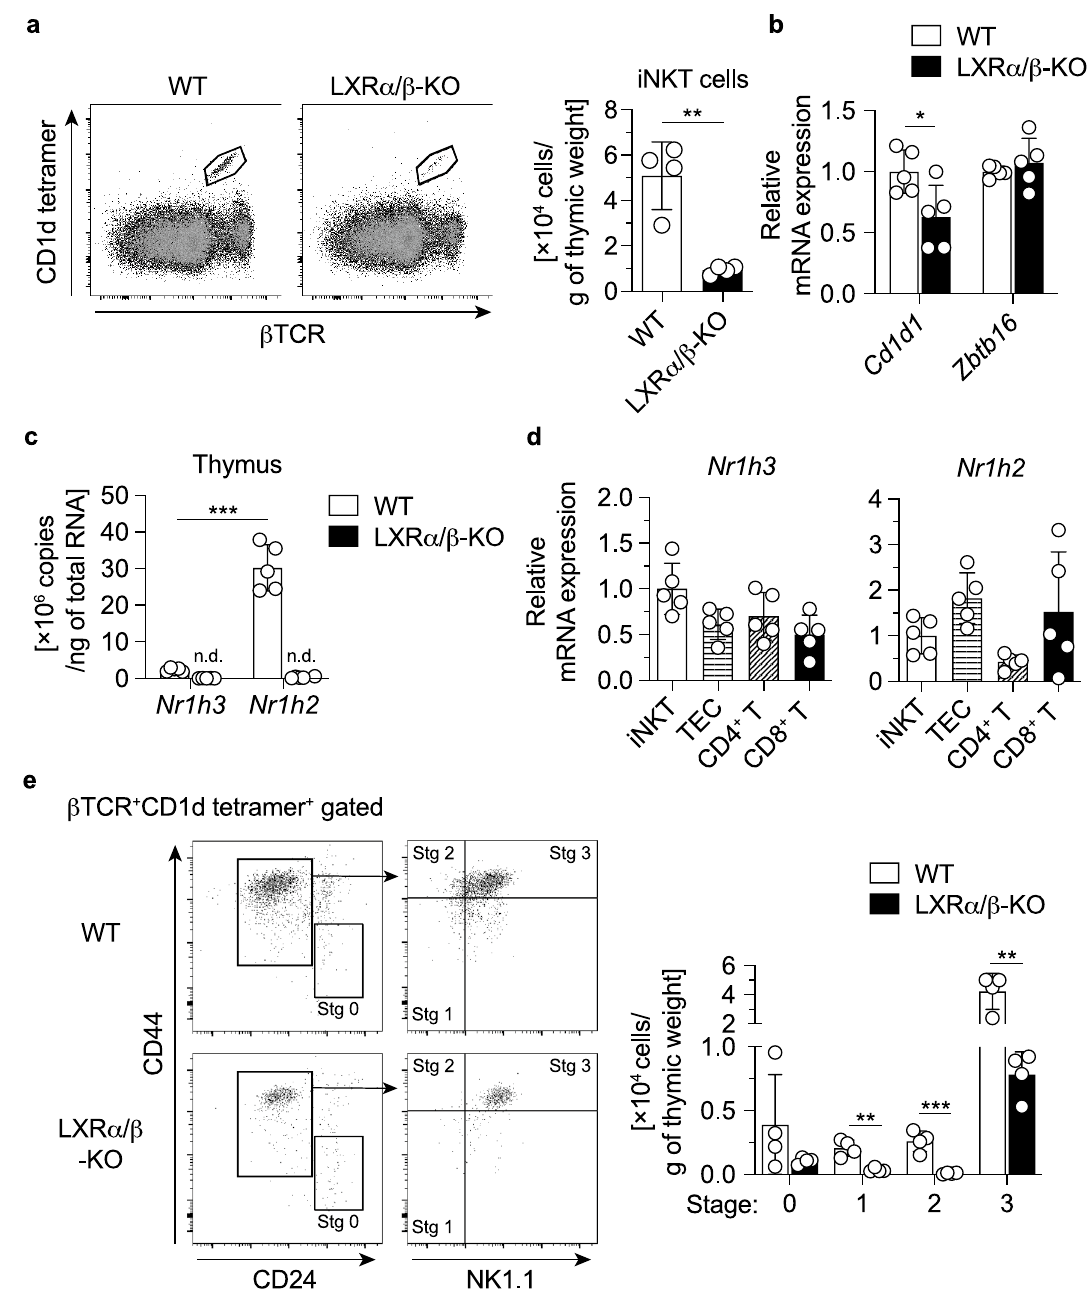
Figure 7. Decreased population of iNKT cells in the thymus of LXRα/β-KO mice. ( a ) Numbers of iNKT cells in thymocytes. ( b ) Cd1d1 and Zbtb16 mRNA expression and ( c ) Nr1h3 and Nr1h2 mRNA expression in the thymus. ( d ) mRNA expression of Nr1h3 and Nr1h2 in iNKT cells, TECs, CD4 + T cells and CD8 + T cells from the thymus. Thymocytes were stained with PE-conjugated CD1d tetramer, FITC-conjugated anti-βTCR, PE-Cy7- conjugated anti-EpCAM and APC-conjugated anti-CD45 to separate iNKT cells (CD45 + βTCR + CD1d-tetramer + cells) and TECs (EpCAM + cells), or with FITC-conjugated anti-βTCR, PE-conjugated anti-CD4 and PE-Cy7- conjugated anti-CD8a to separate CD4 + T cells (CD45 + βTCR + CD4 + cells) and CD8 + T cells (CD45 + βTCR + CD8a + cells). ( e ) The populations of thymic iNKT cells of stage 0, stage 1, stage 2 and stage 3. Thymocytes were isolated from WT and LXRα/β-KO mice, and stained with FITC-conjugated anti-NK1.1, PE-conjugated CD1d tetramer, PE-Cy5-conjugated anti-βTCR, Brilliant Violet-510-conjugated anti-CD24 and APC-conjugated anti-CD44. iNKT cell stages were determined as stage 0 (CD24 + CD44 − ), stage 1 (CD24 − CD44 − NK1.1 − ), stage 2 (CD24 − CD44 + NK1.1 − ) and stage 3 (CD24 − CD44 + NK1.1 + ) in the population of βTCR + CD1d-tetramer + -gated cells (iNKT cells). Stg, stage. * P < 0.05, ** P < 0.01, *** P < 0.001 (Student’s t test). n.d., not detected (around or below detection